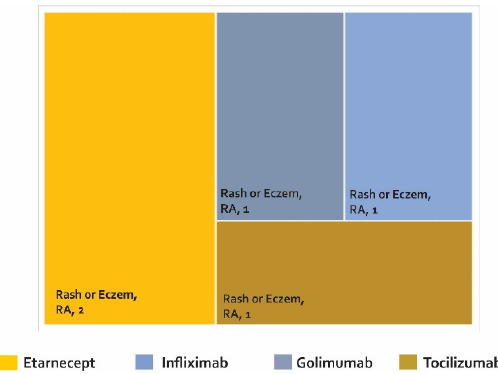
Figure 5. Adverse biotherapeutic events in rheumatic diseases presented in cross-sectional studies [103] .